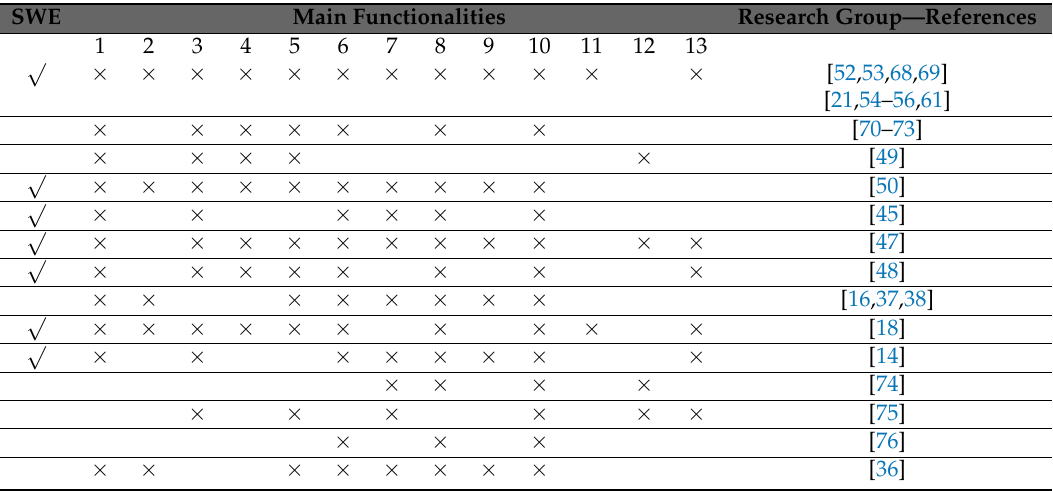
Table 1. Summary of the approaches and their main functionalities. SWE Main